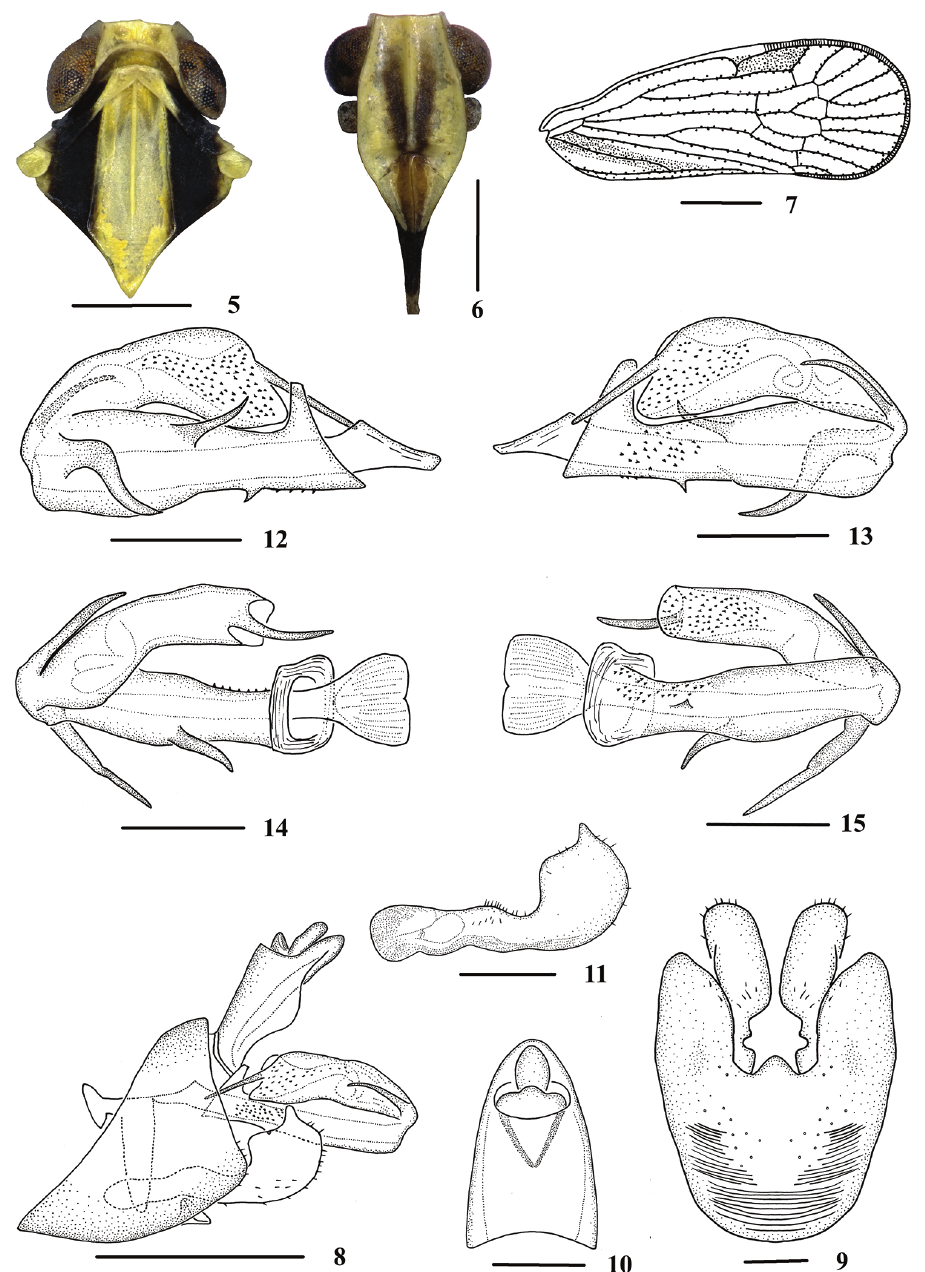
Figures 5–15. Neocarpia acutata sp. n., male 5 Head and thorax, dorsal view 6 Face, ventral view 7 Fore- wing 8 Genitalia, lateral view 9 Pygofer and genital styles, ventral view 10 Anal segment, dorsal view 11 Genital styles, inner lateral view 12 Aedeagus, right side 13 Aedeagus, left side 14 Aedeagus, dorsal view 15 Aedeagus, ventral view. Scale bars: 0.5 mm ( 5–6, 8 ); 1.0 mm ( 7 ); 0.2 mm ( 9–15